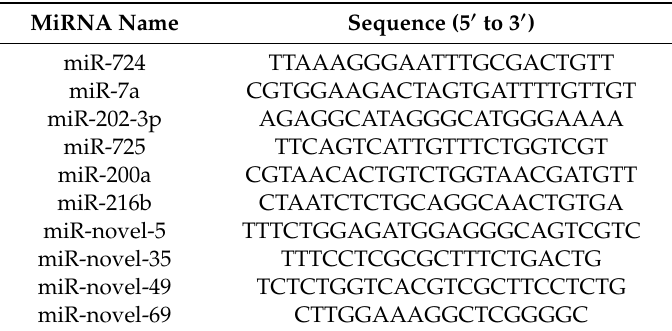
Table A1. The primer sequences used for RT-qPCR.